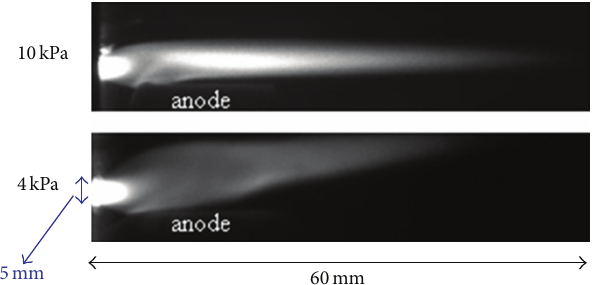
Figure 4: Photographs of the plasma jet in visible light captured by fast shutter camera for chamber pressures 10 kPa and 4kPa. Radial scale is marked using the diameter of the nozzle, which is 5 mm.